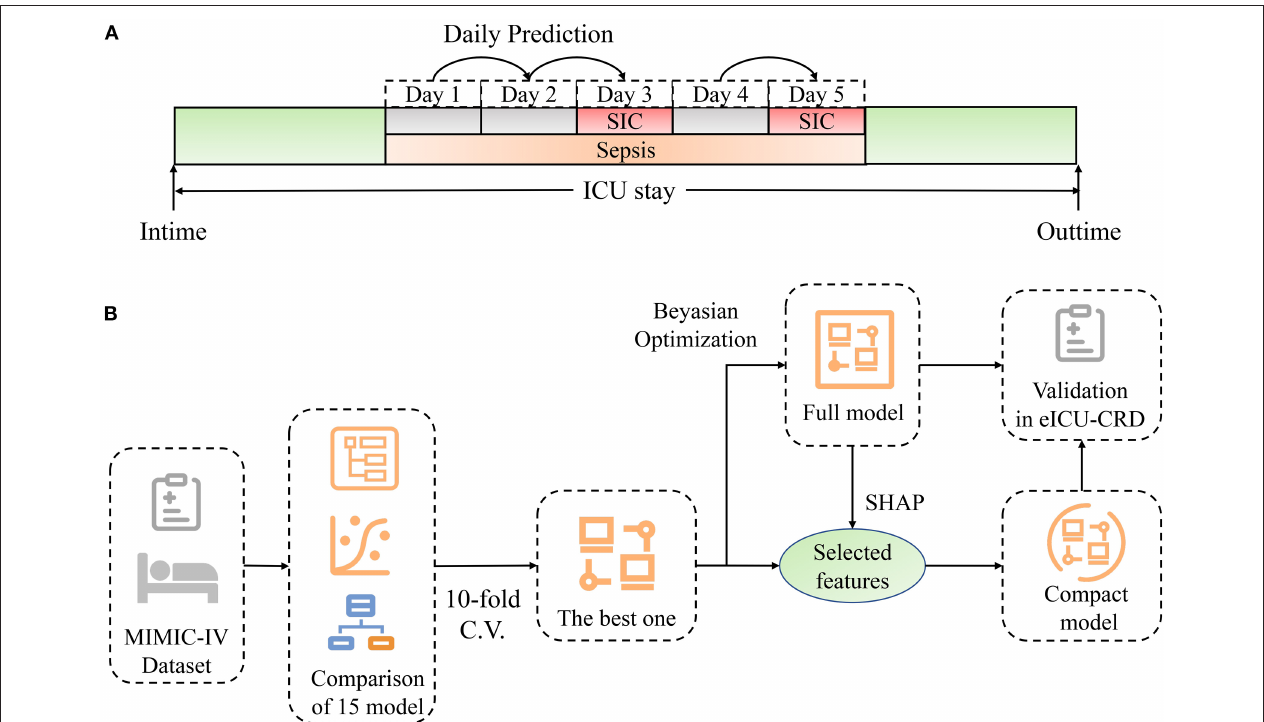
FIGURE 1 | Schematic illustration of the study design. (A) Design of dynamic prediction in our study. Daily assessment was performed from the time when sepsis was diagnosed. If SIC criteria were not fulfilled, the risk of SIC the next day was predicted by our model. Prediction stopped when SIC was diagnosed, and restarted when patients recovered from SIC. (B) Schematic illustration of model development. We compared the discrimination of 15 machine-learning models using 10-fold cross-validation. The model with the best accuracy and greatest AUC was chosen. Fine-grained hyperparameter adjustment was performed using Bayesian Optimization. Fifteen features were selected according to their SHAP values and clinical availability. A compact model was developed based on the selected features. Lastly, these two models were validated in eICU-CRD. ICU, intensive care unit; SIC, sepsis-induced coagulopathy; SHAP, SHapley Additive exPlanations; MIMIC-IV, Medical Information Mart for Intensive Care-IV; C.V., cross-validation; eICU-CRD, the eICU Collaborative Research